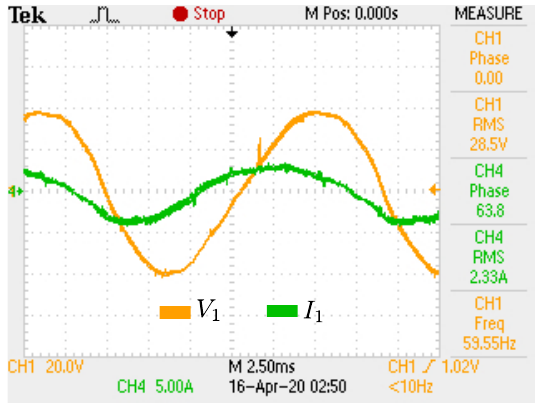
Figure 31. Load voltage and current for phase 1: RC load. Table 7. Comparison between simulated results of single-phase model with experimental results of a three-phase model: RC